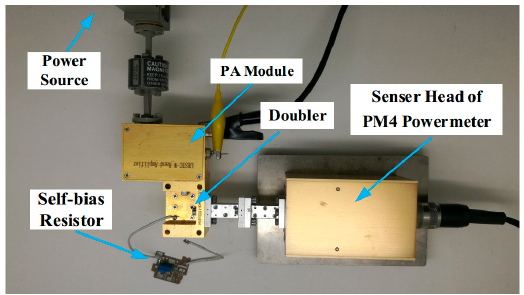
Figure 10. Test platform of the doubler.